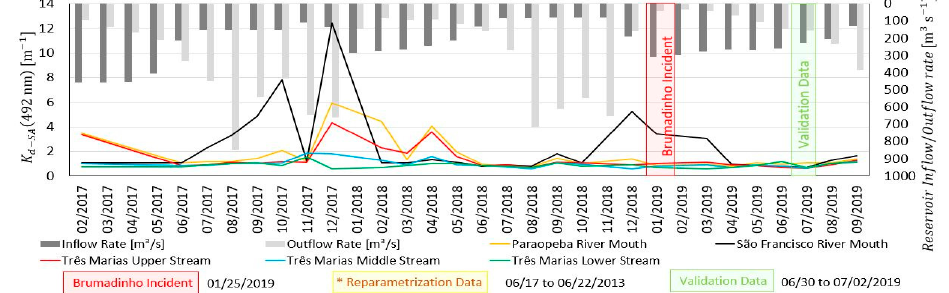
Figure 14. Monthly variation of average K d − SA ( λ ) at MSI bands; monthly-averaged inflow and outflow rates for points at upper stream, middle stream, and lower stream regions of the reservoir. *, reparametrization data does not appear in the image time-series.